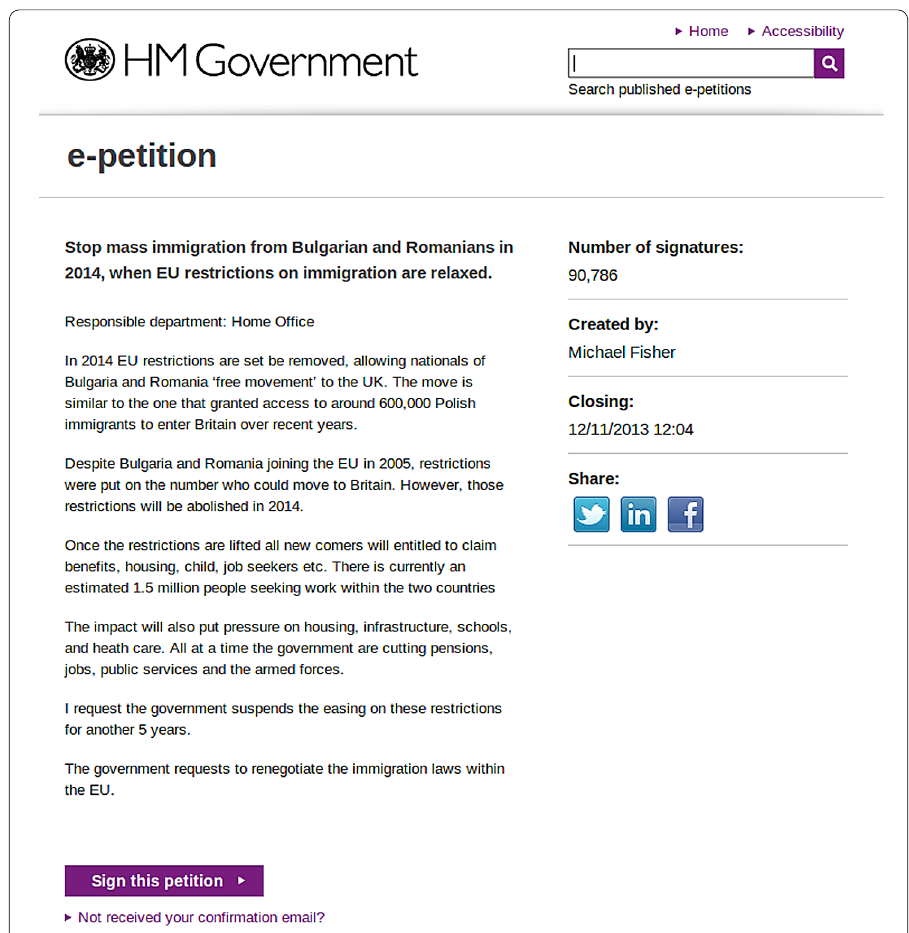
Figure 1 A snapshot of a petition on the http://epetitions.direct.gov.uk site. The platform was launched by the UK Cabinet Office for the Coalition Government in August